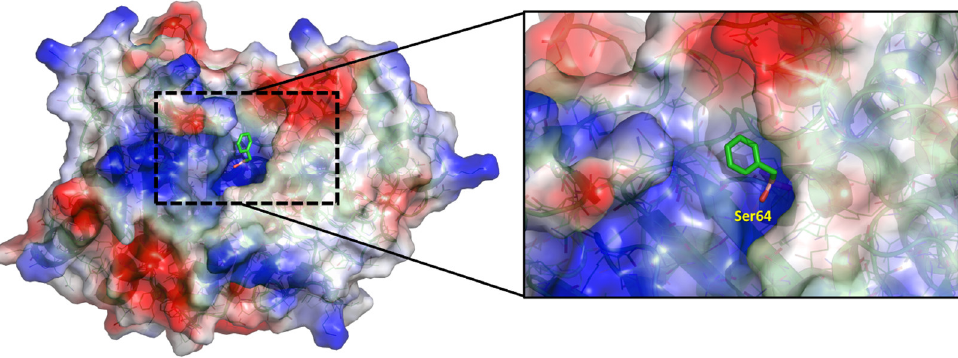
Figure 2. Binding mode of BCC 2 in the active site of AmpC, which resulted from docking calculations.